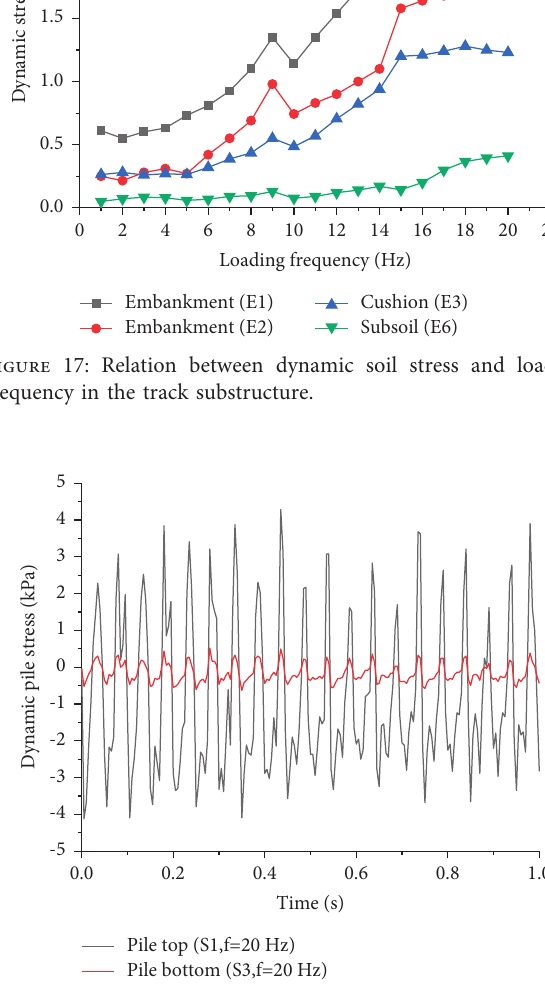
Figure 18: Time history analysis of dynamic stress at pile top and bottom for f � 20Hz.